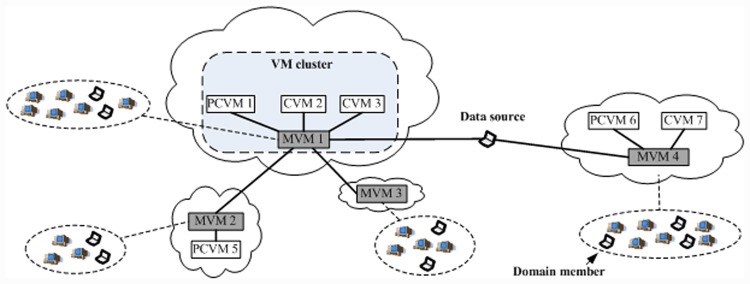
VMCast structure.